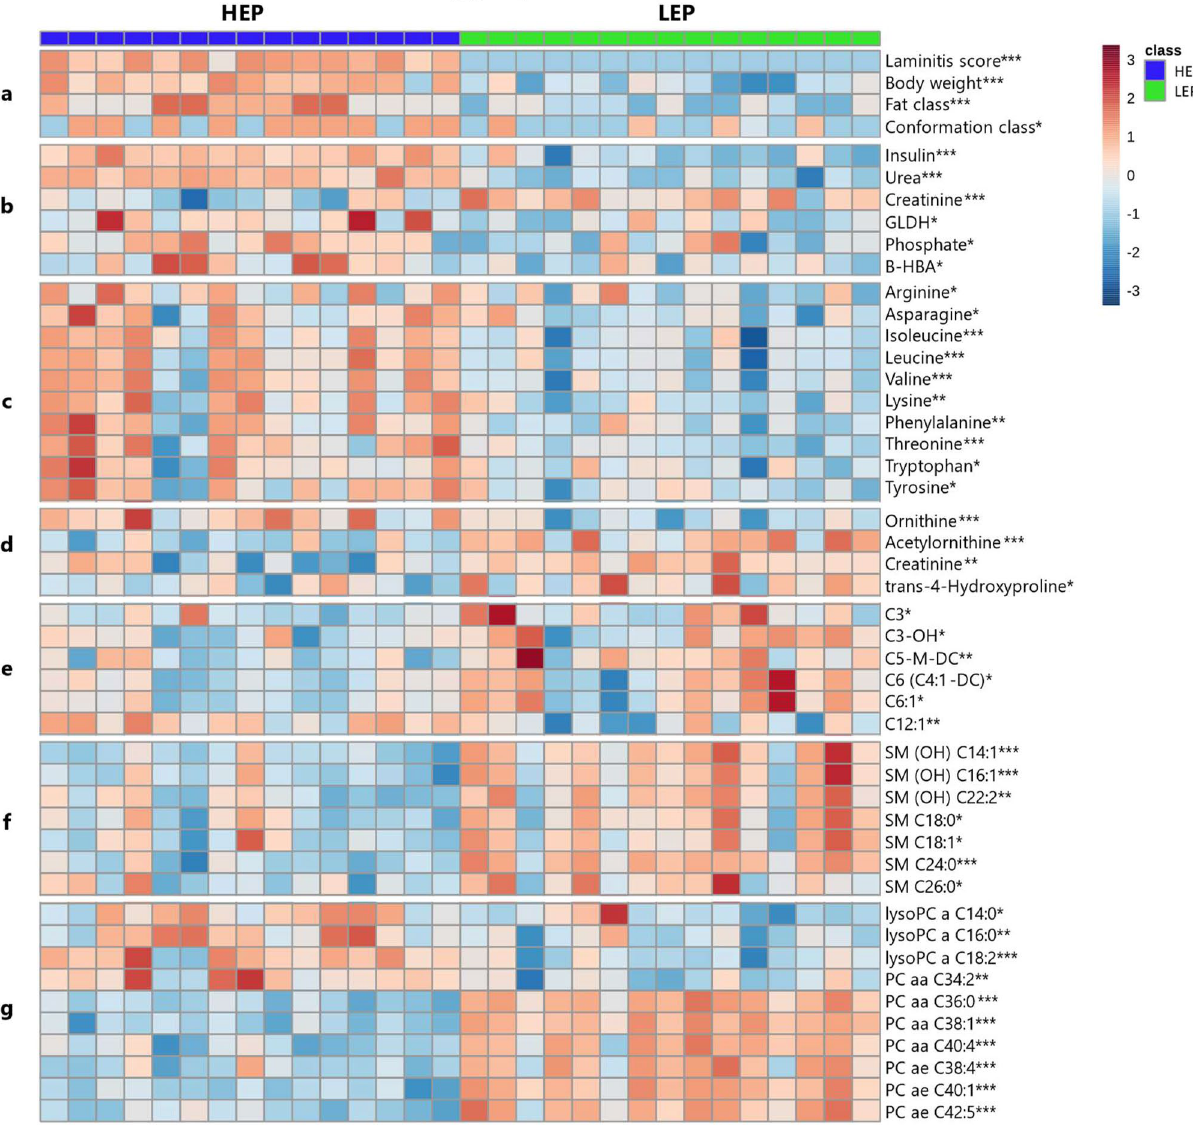
Figure 5. Heatmap visualizing all differentiating metabolites of interest at slaughter of bulls fed high energy and protein (HEP) and low energy and protein (LEP) diet, including ( a ) claw disease and growth performance, ( b ) insulin and blood biochemistry, ( c ) amino acids, ( d ) amino acids related, ( e ) acylcarnitines, ( f ) sphingomyelins (SM), ( g ) lyso-phosphatidylcholines (PC), PC aa 34:2 and 6 representative diacyl (aa) and acyl-alkyl (ae) PC. Each column represents one animal’s metabolite profile. All significantly different results are shown in Supplementary Table S1, n = 15, *P < 0.05, **P < 0.01, ***P < The effects of the dietary regimens can only be evaluated as a whole, and testing interactions between feed components was not possible. The HEP bulls showed higher daily weight gains and final live weights than the LEP group, consistent with other studies which compared different fattening intensities 4,17 . The increased energy and protein intake led to a greater muscle fullness, but even more clearly to an adiposity of the animals. This could indicate that the 20 months old animals reached nearly the limit of their protein accretion capacity and excess energy has been used mainly to increase fat depots. As a dairy breed, Holstein bulls have a lower ability of muscle accretion and a higher preference for fat deposition in comparison to beef breeds 18 . A shortened fattening period to compensate for this breed-related feature was not implemented, which possibly increased the negative effects of the HEP diet on the animals. A changed body mass composition with higher fat content is often associated with negative metabolic consequences. Summarized in various reviews, nutrient excess and obesity can lead to mitochondrial dysfunction, oxidative stress and also membrane and ER stress, which promotes impaired insulin signaling and increased inflammatory cytokine production 19 . Obesity in humans can lead to increased inflam- matory mediators 20 , reduced insulin sensitivity or insulin resistance and type 2 diabetes 21,22 . This is similar to